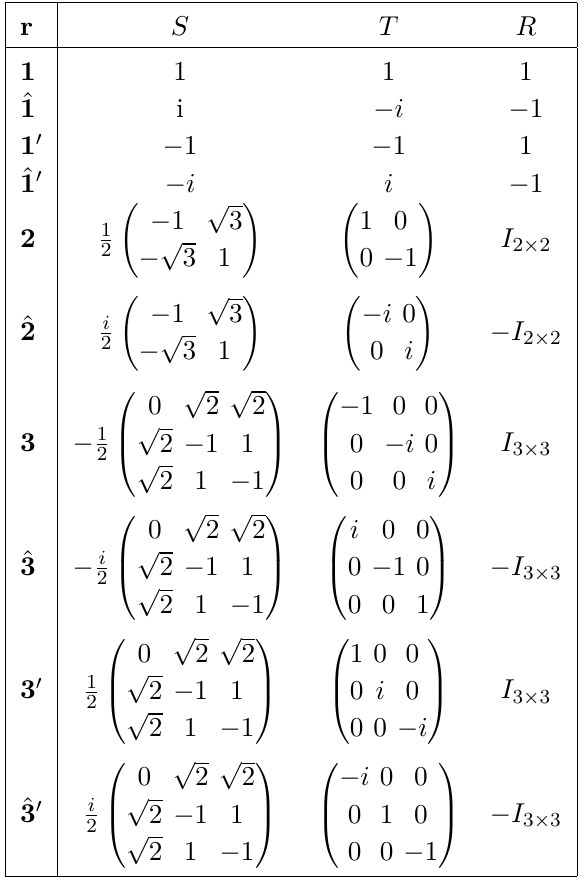
. Our notation is based on 4